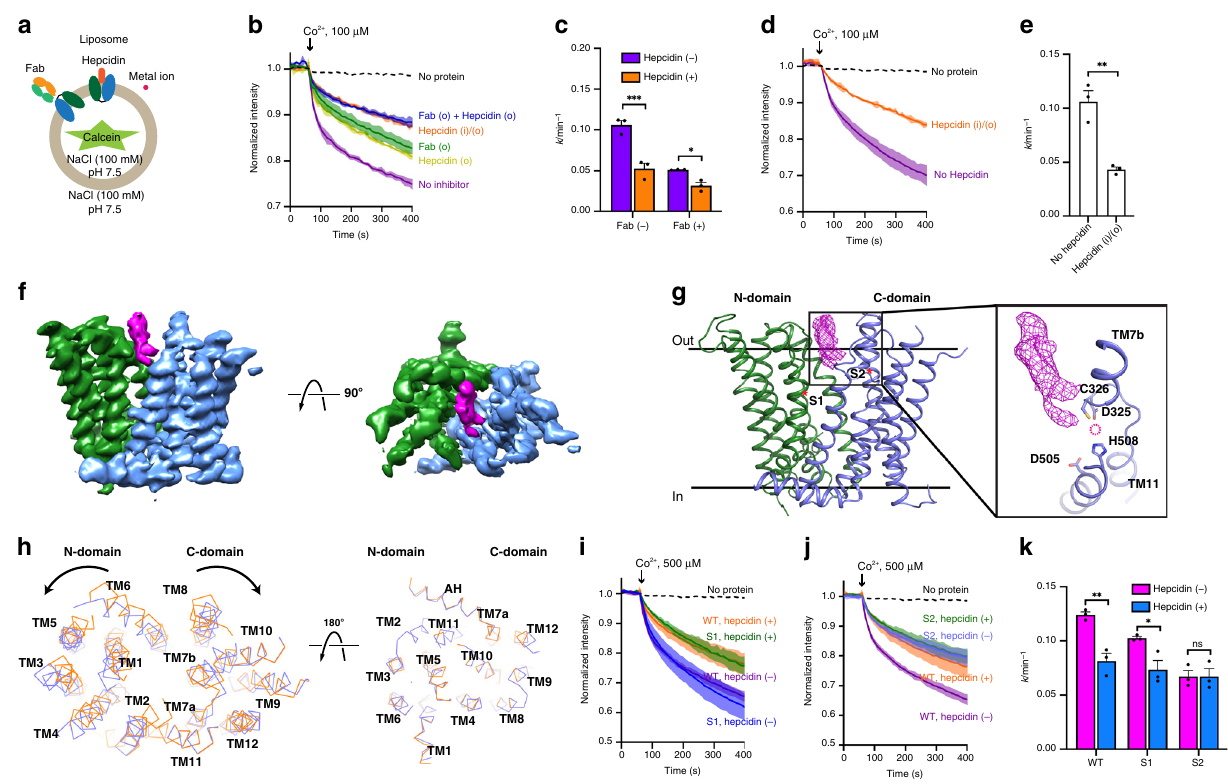
Fig. 5 Hepcidin inhibition of TsFpn. a Schematic view of orientation-speci fi c binding of hepcidin and Fab to TsFpn in proteoliposomes. b Fluorescence quench mediated by TsFpn with no hepcidin (purple), with hepcidin on the outside (light green), with Fab on the outside (green), with hepcidin on both in- and outside (orange), and with both Fab and hepcidin on the outside (blue). c Initial rate constants of Co 2 + uptake in the presence of different inhibitors. Two-way ANOVA: interaction, p = 0.0083. Within each group, statistical signi fi cances are indicated: * p < 0.05; *** p < 0.001. d Fluorescence quench mediated by human Fpn with no hepcidin (purple), with hepcidin on both inside and outside (orange). e Initial rate constants of Co 2 + uptake. Two-tailed Student ’ s t test: ** p < 0.01. f Cryo-EM map of TsFpn (green and blue) in complex with hepcidin (magenta) in two orientations. The Fab density is not shown. g Structure model of TsFpn in the presence of hepcidin. Hepcidin density is shown as magenta mesh. Positions of S1 and S2 are labeled as red stars. Inset: close-up view of hepcidin density and the S2 site. Co 2 + position is marked as a dotted circle. h Overlay of TsFpn structure with (blue) and without hepcidin (orange), viewed from the extracellular (left panel) and intracellular side (right panel). The relative movement of N- and C-domains is marked with arrows. i , j Fluorescence quench mediated by the S1 ( i ) and S2 ( j ) mutations in the presence or absence of hepcidin. k Initial rate constants of Co 2 + uptake of WT and mutants with or without hepcidin. Two-way ANOVA: interaction, p = 0.015; within each group, statistical signi fi cances are indicated: ns not signi fi cant; * p < 0.05; ** p <